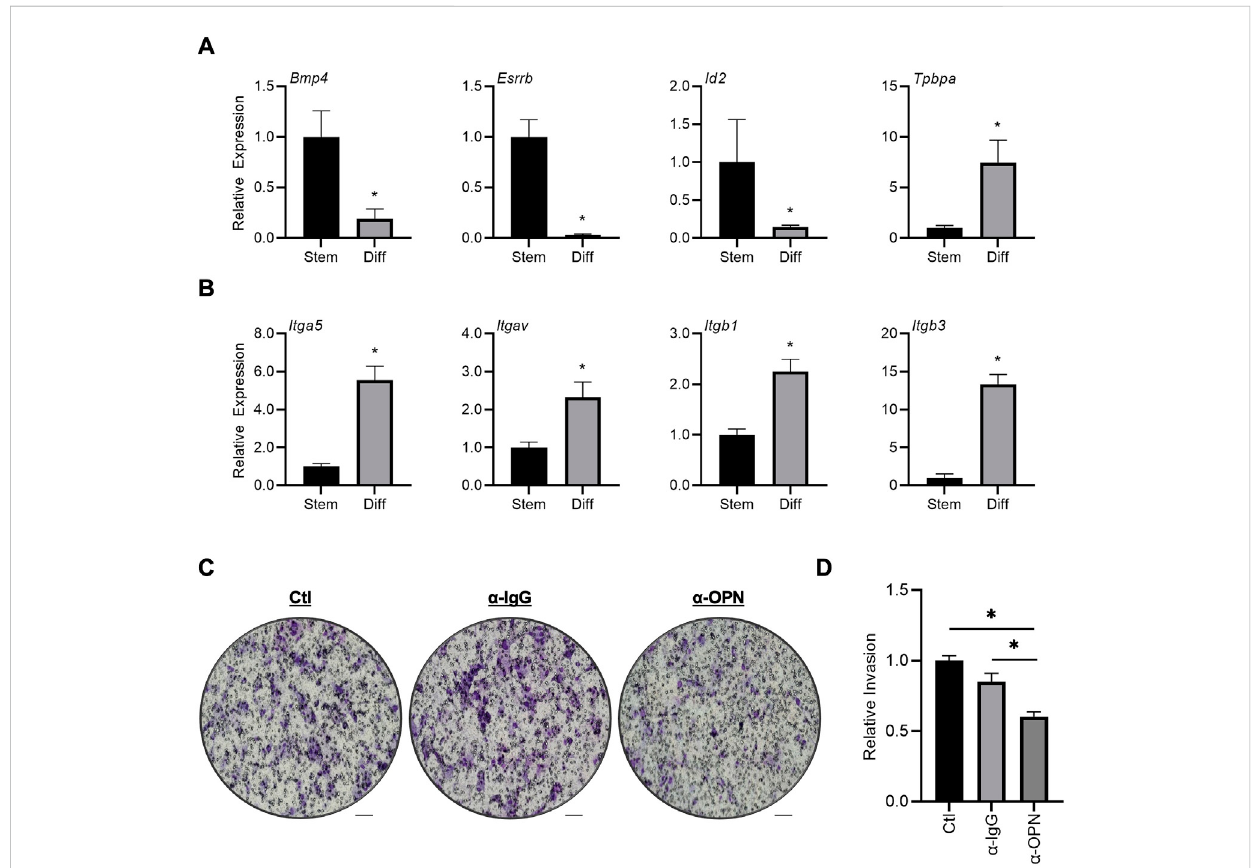
Neutralizing OPN in decidual conditioned media decreases invasiveness of rat trophoblast cells. (A) Expression of genes associated with the stem state( Bmp4 , Id2 ,and Esrrb )orjunctionalzonetrophoblasts( Tpbpa) afterculturingTScellsinstemconditions(Stem)orafter6daysofdifferentiation(Diff). (B) Expression of genes encoding various integrin subunits (putative OPN receptors) in TS cells cultured in Stem or Diff conditions. (C) Representative imagesofTranswellmembranesshowingdifferentiatedtrophoblaststhatinvadedtotheundersideofthemembraneafter24 hexposuretodecidual conditionedmedia(Ctl),orconditionedmediasupplementedwithnon-speci fi cIgG( α -IgG)oranOPNneutralizingantibody( α -OPN).Scalebars,100 μ m. The relative number of cells that invaded in each condition is graphically depicted in (D) . The experiment was conducted 4 times, with 3